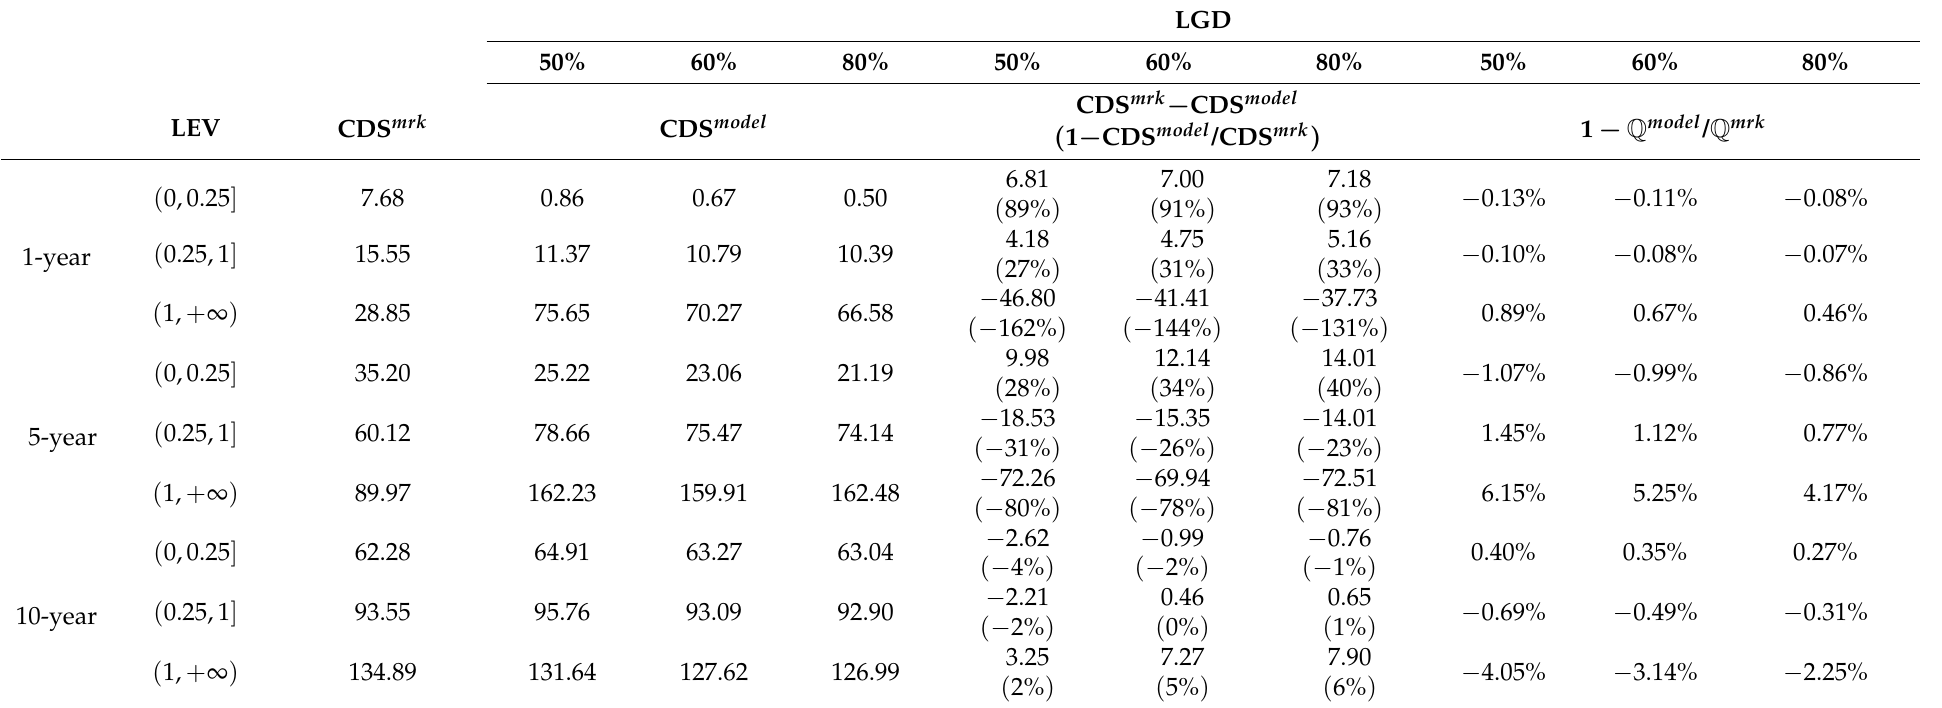
Table 3. Pricing error of the CDS spread and risk-neutral probabilities of default for w = 1/3. All the model-implied spreads are calculated setting the loss given default equal to 50%, 60% or 80%. This allows to jointly test for the effect of the aggregation scheme in the firm’s capital structure and on the selected value of LGD. The table reports the market CDS spread alongside those produced by the model (expressed in basis points) based on the estimates of the firm’s asset and volatility on the previous week. The results are clustered based on the maturity of the CDS contract (1, 5, and 10 years) and on the firm’s average leverage. A positive/negative pricing error CDS mrk − CDS model indicates that the model under/overpredicts the level of the spread. This is reflected into the over/underprediction of the survival probabilities. Errors are also reported as percentages in brackets. For the probabilities of survival, only percentage errors are reported. Based on leverage, the numbers of companies in each bucket are N ( 0,0.25 ] = 44, N ( 0.25,1 ] = 15, N ( 1, + ∞ ) =